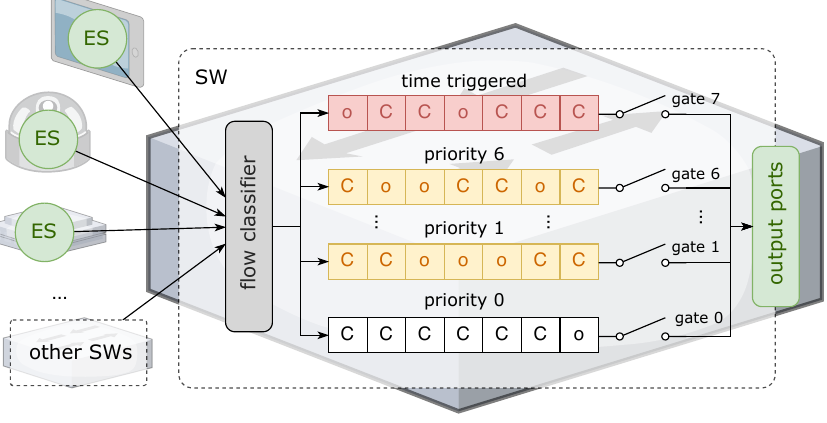
Figure 8. TAS scheduling mechanism with GCLs in a